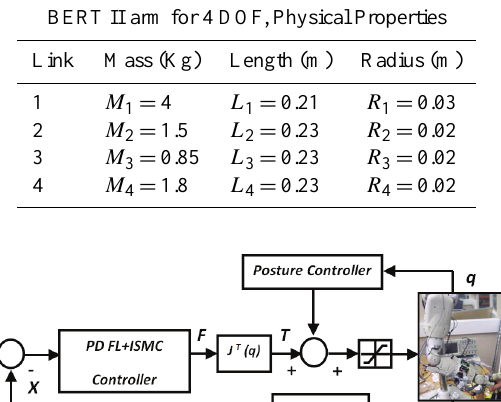
Table 1. Physical Properties of BERT II arm.